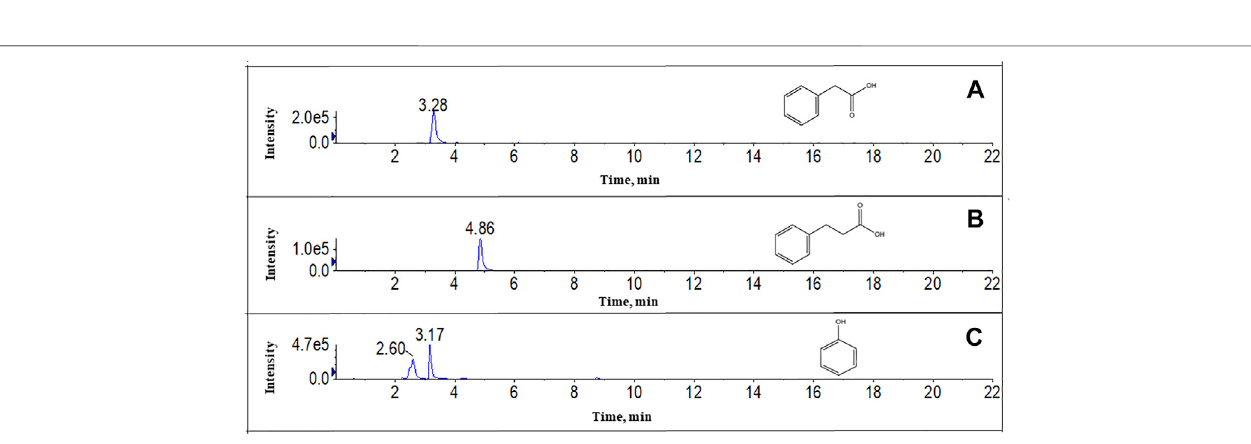
Frontiers in Environmental Science |